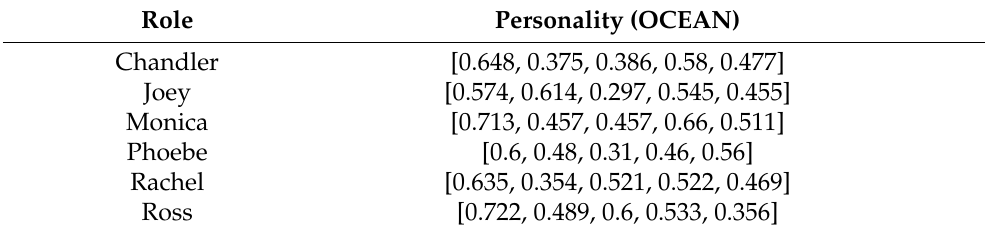
Table 2. Six OCEAN personality vectors in